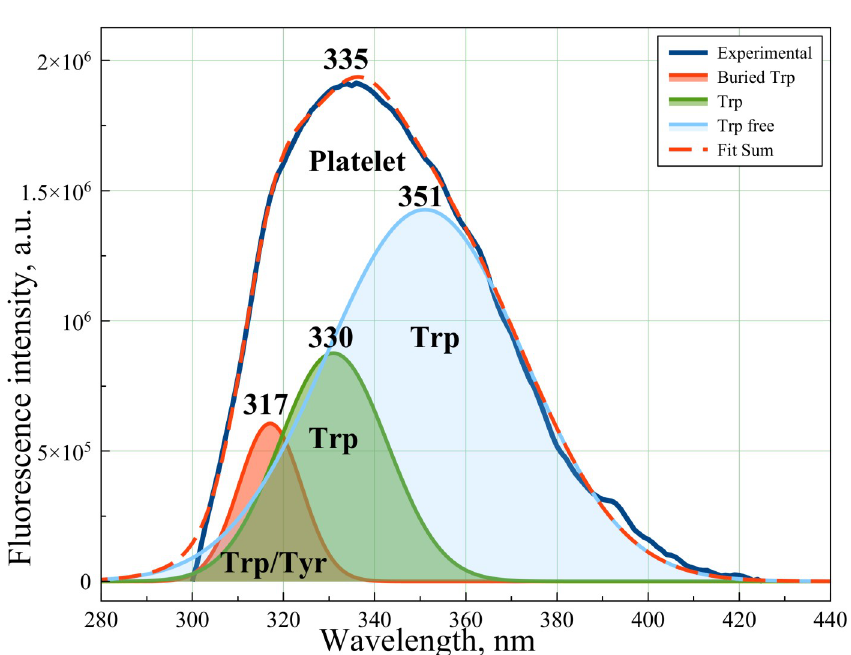
Fig 8. Results of Gauss modeling for platelet experimental fluorescence curve (dark blue line) including: Free Trp curve (blue line), Trp on the platelet membrane (green line) and Trp buried/masked Tyr residue (red solid line).